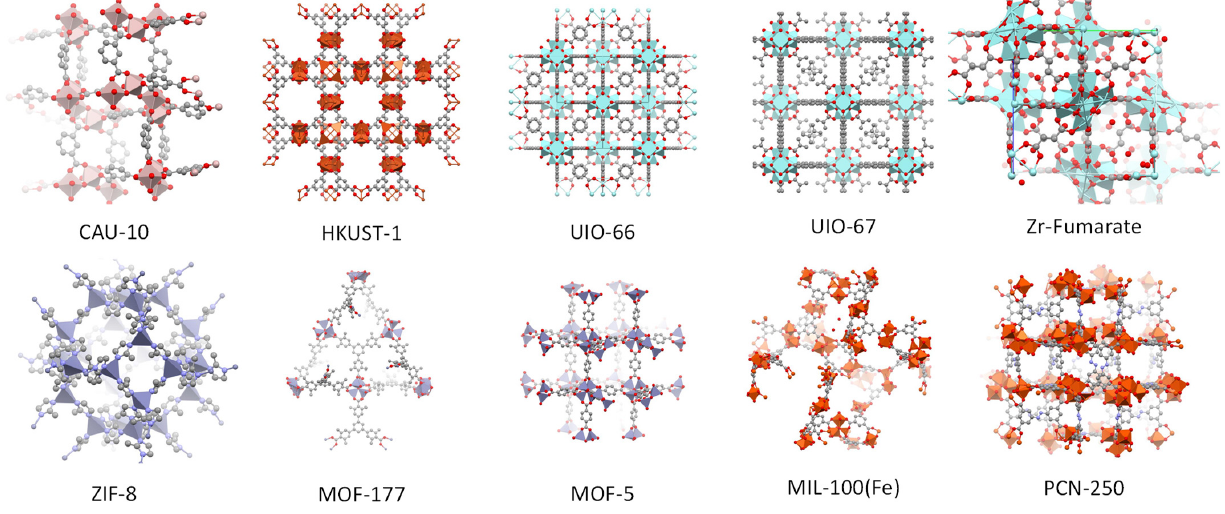
Figure 1. Used commercially available MOFs in this work. Structures from CSD deposition codes OQOCAA, LUDLED, RUBTAK, WIZMAV02, BOHJOZ, OFERUN, SUGSEU, MIBQAR, CIGXIA, XOXTOW, respectively, from top-left to down-right (hydrogen atoms were omitted for clarity).